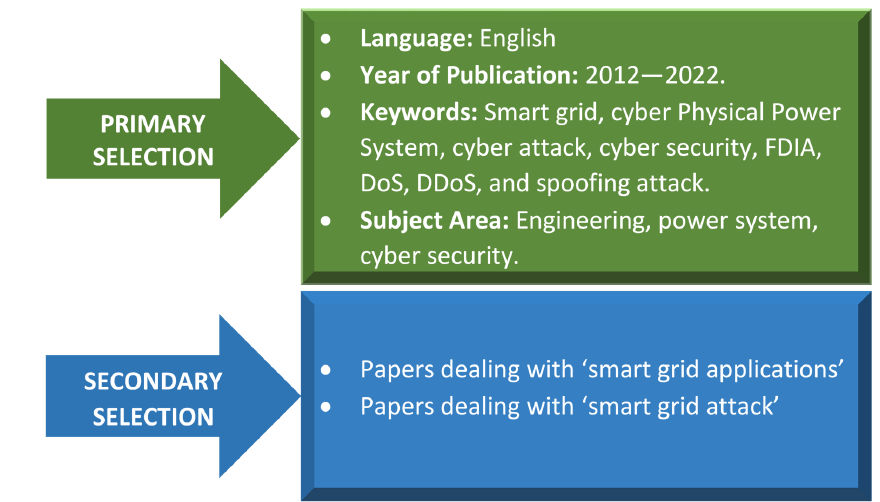
Figure 2. Research papers selection